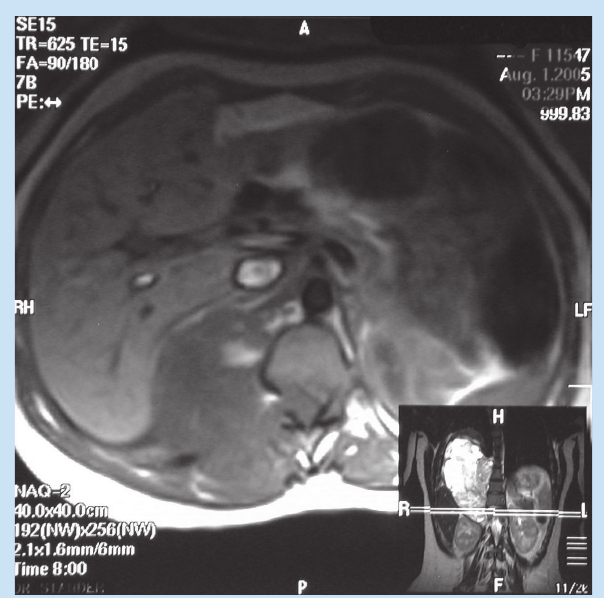
Fig. 3. This T1-weighted axial image shows a right paraspinal mass isoin- tense to muscle. Haemorrhage can be seen as a hyperintense area in the mass. Invasion of the chest wall and erector spinae muscles is seen on the right. The mass extends into the spinal canal via the intervertebral foramen with subsequent widening of the foramen. The spinal cord is compressed and displaced anteriorly and to the